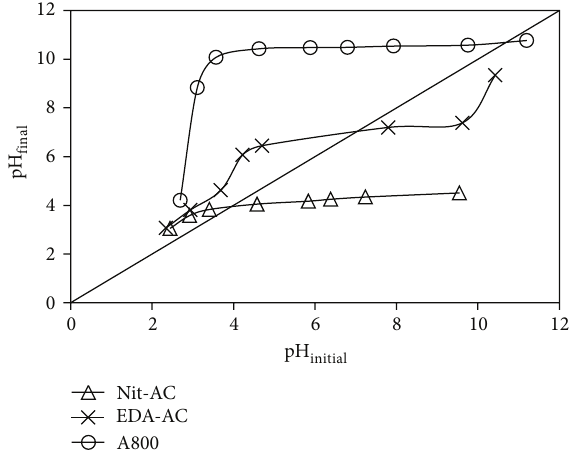
Figure 4: Determination of pH of point of zero charge for activated carbon